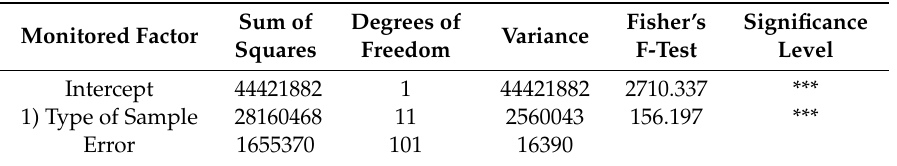
Table 12. Statistical evaluation of the e ff ect of the factors and their interaction on the minimum bend radius at the yield point ( R minC ) for aspen and NWC on top.